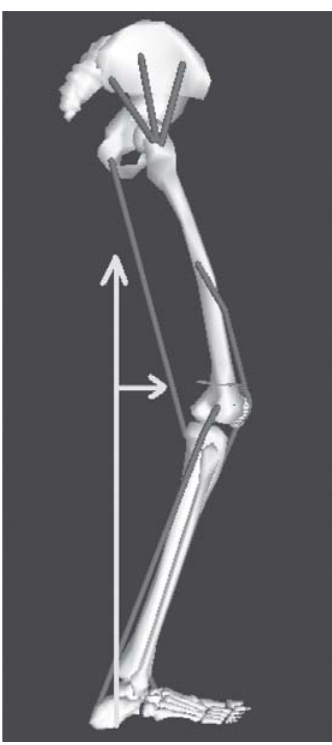
Figure 1 - Crouch Gait: increase knee flexion during stance phase and the external flexion